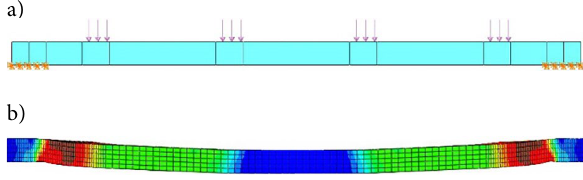
Figure 3. Stress-strain curvature for MW core